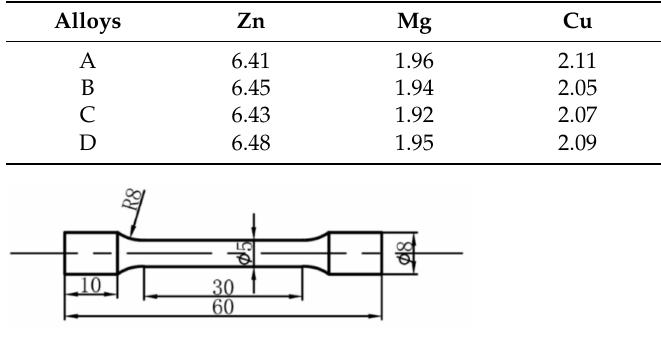
Figure 1. The diagram of tensile sample.